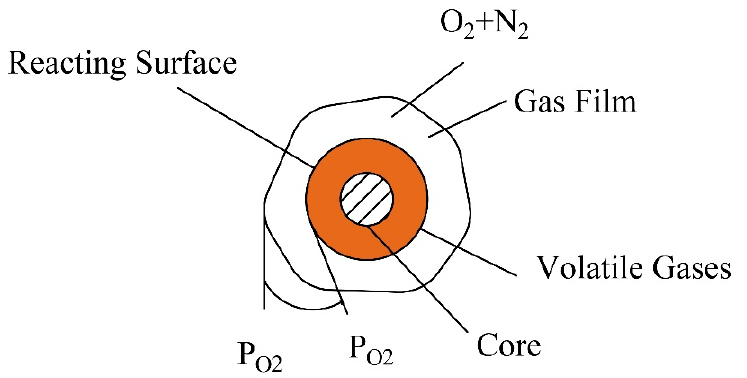
Figure 3. The torrefaction of a pellet in a nitrogen atmosphere.